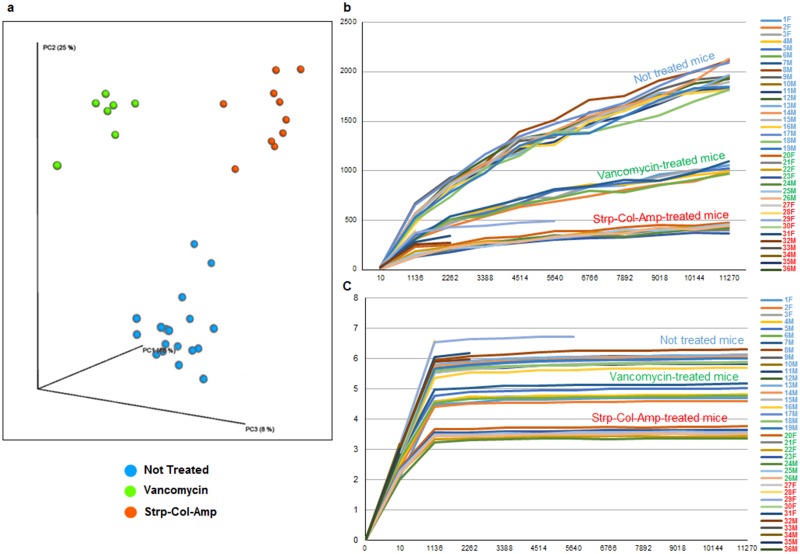
Impact of the antibiotic treatment on Alpha and Beta-diversity of mice microbiota.Panel (a) shows a three dimensional representation of the PCoA analysis. Panels (b) and (c) show the rarefaction curves obtained using the Chao1 and Shannon indexes, respectively.